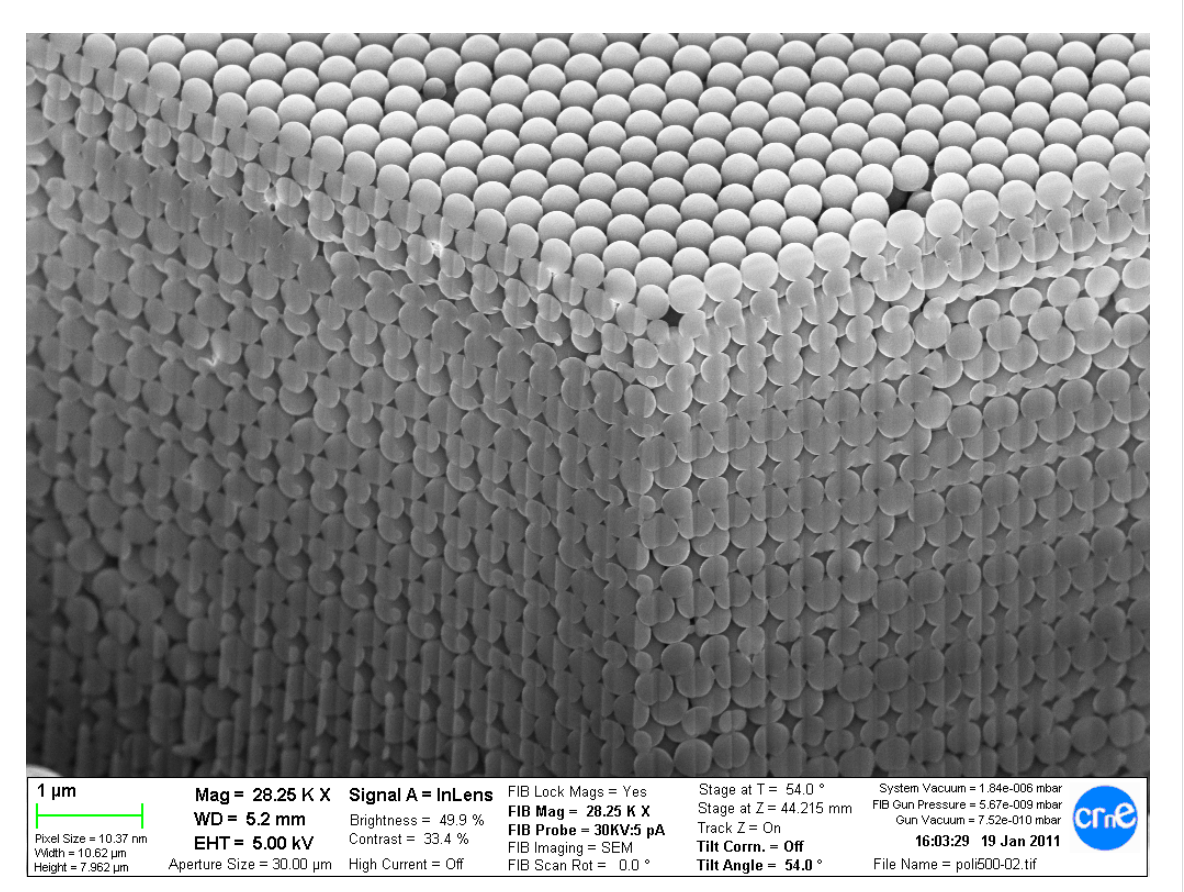
Figure 2: Two cross sections at 90° of a 360 nm polystyrene nanoparticle colloidal crystal. Reprinted with permission from [37], copyright Coll et al.